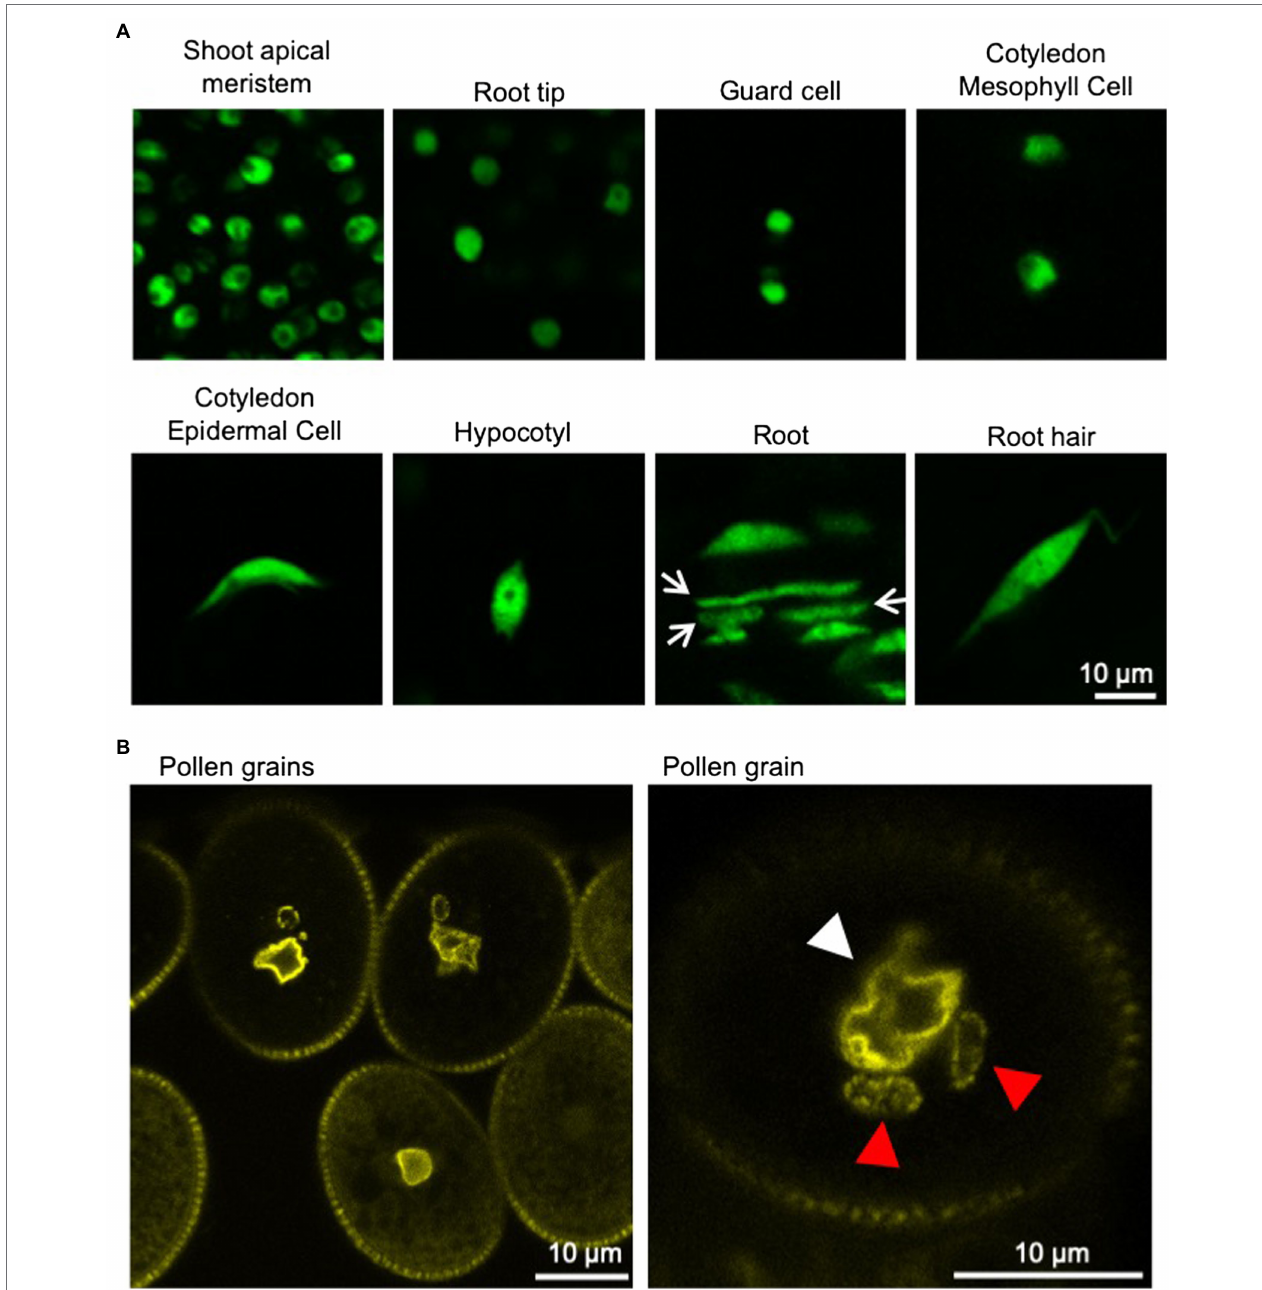
FIGURE 1 | Nuclei in various tissues of Arabidopsis thaliana . (A) Confocal microscope images of nuclei in various tissues of 6-day-old A. thaliana seedlings stably expressing GFP-tagged histone protein (HTA8-GFP) under the control of 35S promoter. Spherical-shaped nuclei are observed in shoot apical meristems, root tips, guard cells, and cotyledon mesophyll cells (upper panels). Spindle-shaped nuclei are observed in cotyledon epidermal cells, hypocotyls, root cells, and root hairs (lower panels). Rod-shaped nuclei (arrow) are also observed in roots. (B) Confocal microscope images of nuclei in pollen grains of A. thaliana stably expressing YFP-tagged nucleoporin protein (RAE1-EYFP) under the control of 35S promoter (Goto et al., 2020). Fluorescently labeled NE clearly shows the irregular shapes of the VNs (white arrowhead). Sperm cell nuclei (red arrowhead) are often